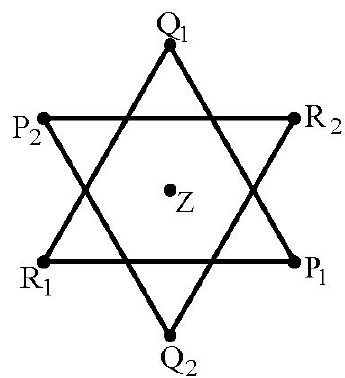
Figure 3 and referred aperture P Q R . The positional magnifi- 2 2 2 cation is X = − 1 . Referral rotates the shape through 180 ° . y ,1 → 2 In contrast to the circular aperture in Figure 4 the referred aper- ture is distinguishable from the aperture. To describe the change as turning the shape upside down is not correct for that would require R and P to be 2 2